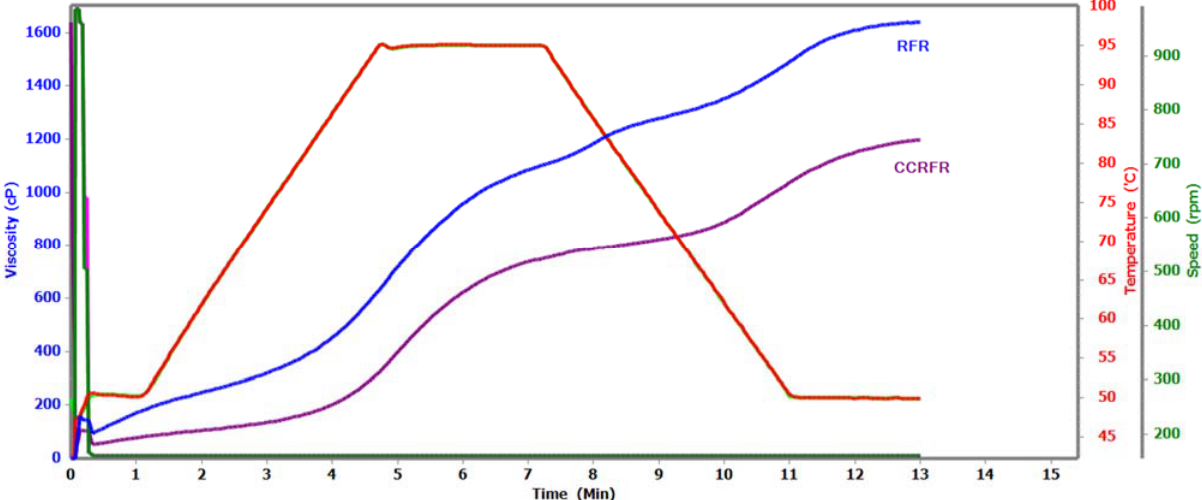
Figure 5. Cross sectional (CS) view and micrograph of uncoated (RFR) and coated roasted flaked rice (CCRFR).